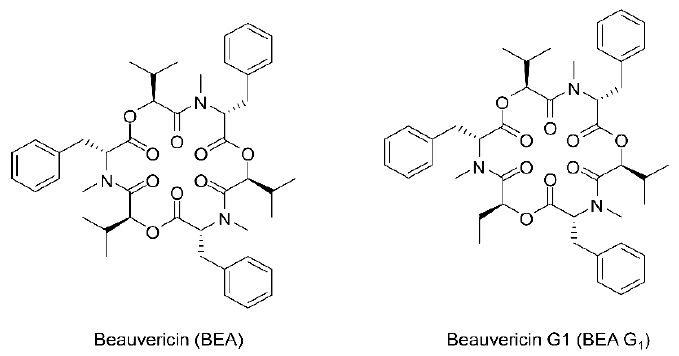
Figure 1. Chemical structures of BEA and BEA G 1 .